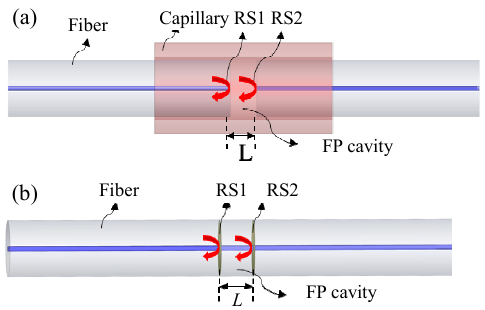
Fig. 11 Schematic diagrams of (a) EFPI sensor with an external air cavity and (b) IFPI sensor formed by two reflecting surfaces, RS1 and RS2, along a fiber. RS1: the first reflective surface; RS2: the second reflective surface.